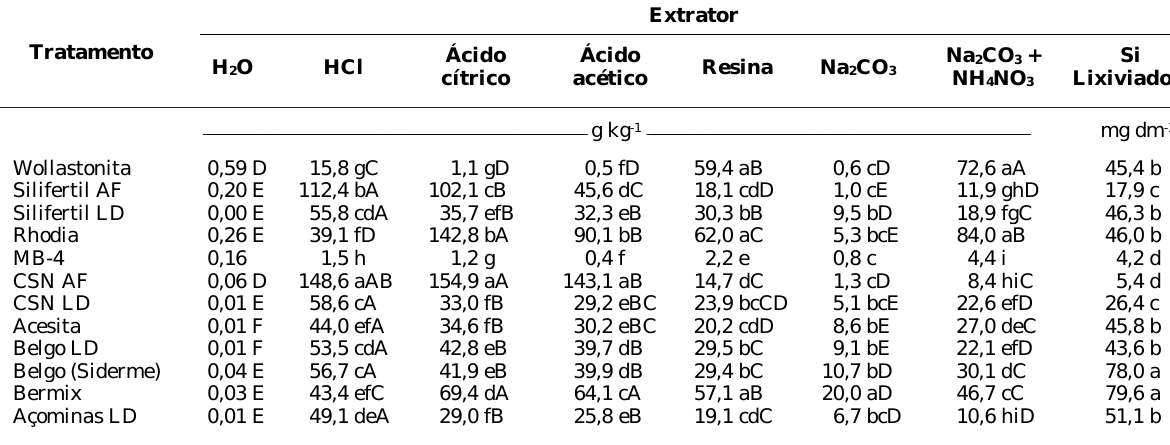
(1) Excluída da análise fatorial, há diferença de unidades entre os valores numéricos. Letras minúsculas indicam diferenças entre os tratamentos na coluna de um mesmo extrator a 5 %. Letras maiúsculas indicam diferenças entre os extratores na linha de uma mesma fonte de Si a 5 %.